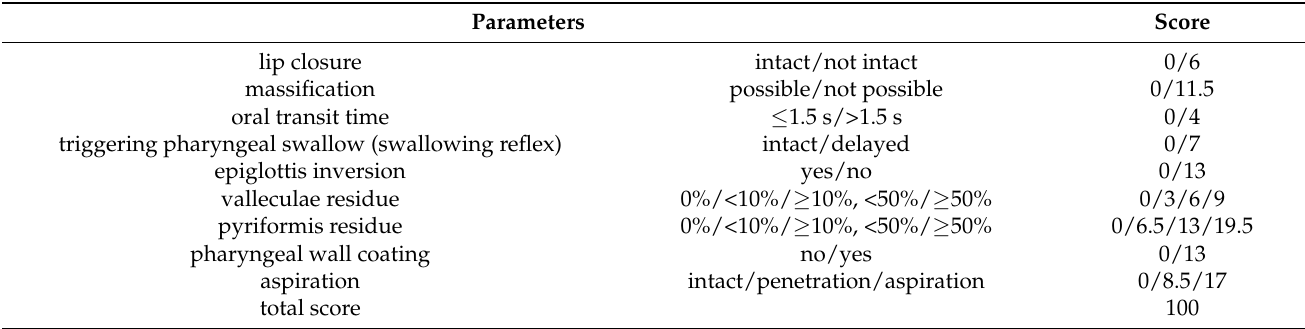
Table 1. Modified version of the videofluoroscopic dysphagia